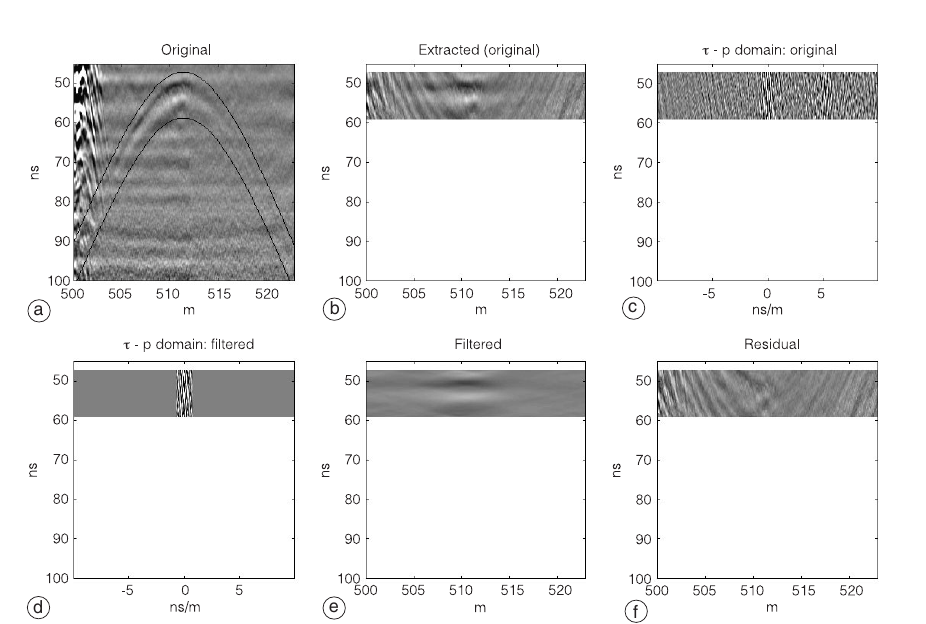
Fig. 6a-f. Example 3: surface-scattering removal by means of the linear Radon transform ( t -p transform) on a hyperbolically windowed data matrix.